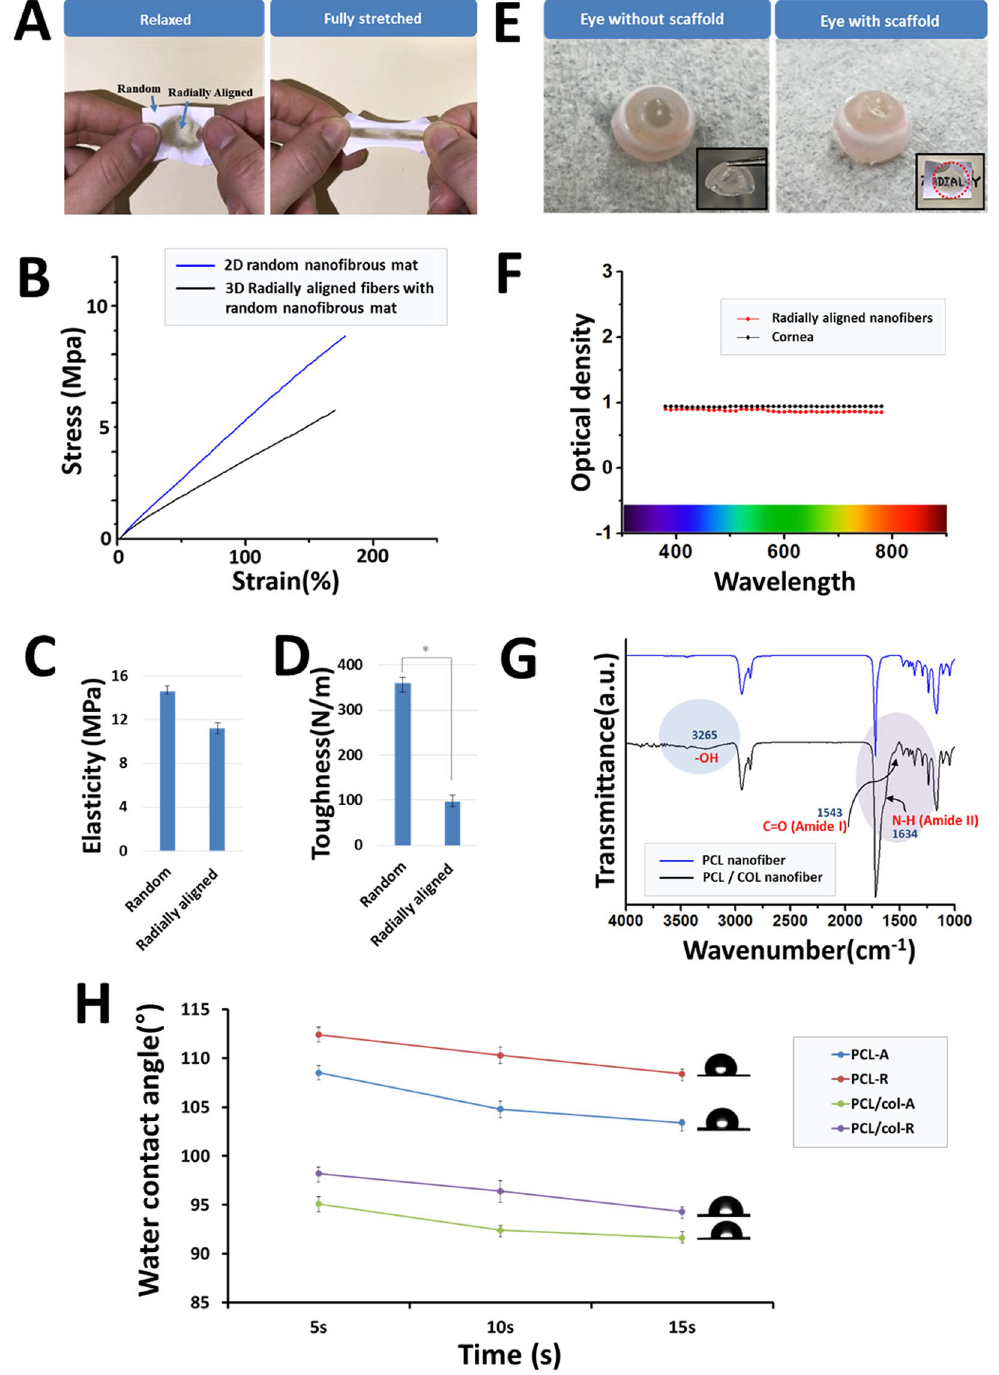
Figure 5. ( A ) Radially aligned nanofibrous mat with relaxed (left) and fully stretched (right). ( B ) Representative stress-strain curves of the radially aligned PCL/collagen mats. ( C , D ) Toughness and elasticity of PCL/collagen mats (radially aligned and randomly oriented nanofibrous mats), showing the single mat of a radially aligned nanofibrous mat in the form of a 3D hemisphere. ( E ) Digital photographs of an eye without the scaffold and an eye with the scaffold (inset: digital photographs of cornea and a mat. The letters confirm the transparency of the radially aligned nanofibrous mat). ( F ) Transparency results using spectrum analysis method in the wavelength range of 400 nm–800 nm. ( G ) FT-IR spectra of the PCL and PCL/collagen nanofibrous mats. ( H ) Water contact angle plot of the PCL and PCL/collagen nanofibrous